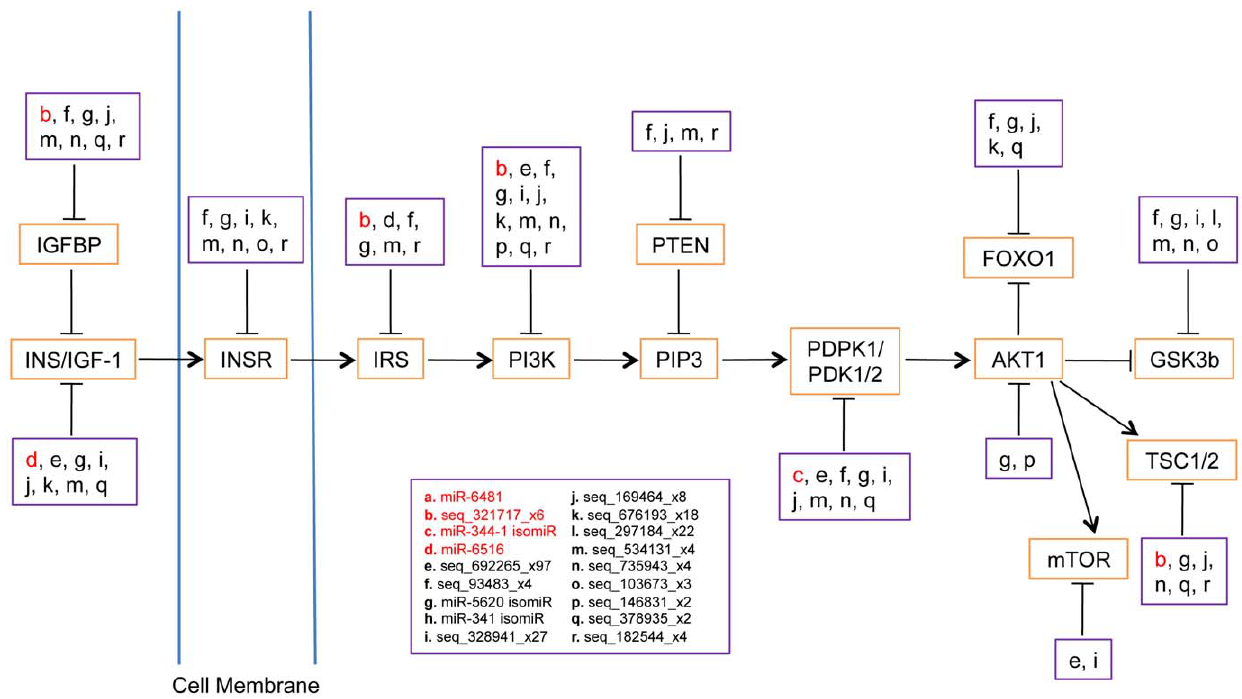
Figure 4. The insulin signaling pathway is predicted to be targeted by many aging-regulated novel miRNA candidates. Multiple novel miRNA candidates are predicted to target each of the genes implicated in the pathway, and each novel miRNA candidate is predicted to target multiple genes in the pathway. In red: upregulated ( . 2.0-fold) novel miRNAs; in black: downregulated ( . 2.0-fold) novel miRNAs.